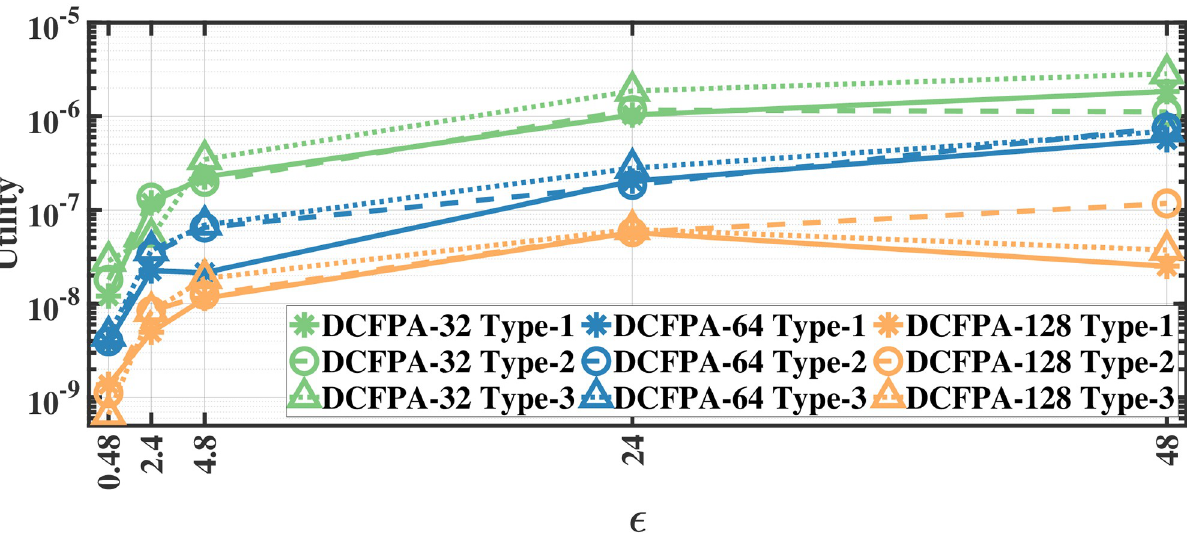
Fig 12. Utility of the DCFPA for